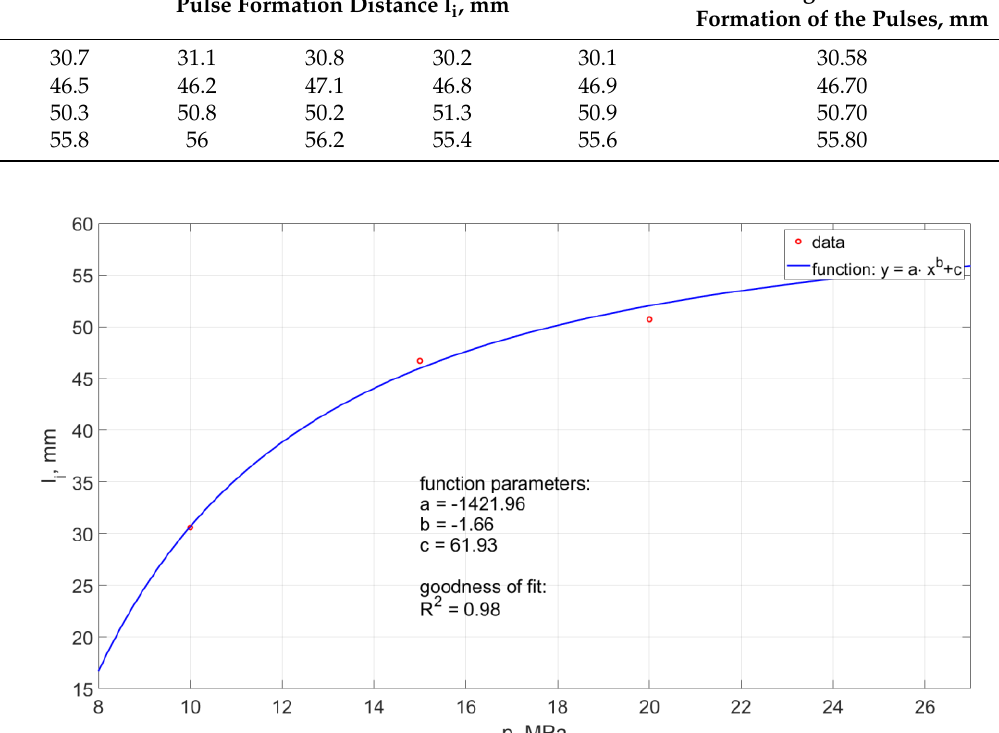
Table 7. Measurements of the distance between the shaping of hydrodynamic impulses in the water stream flowing from the outlet nozzle of the head intended for drilling holes, working in the water environment. lp.